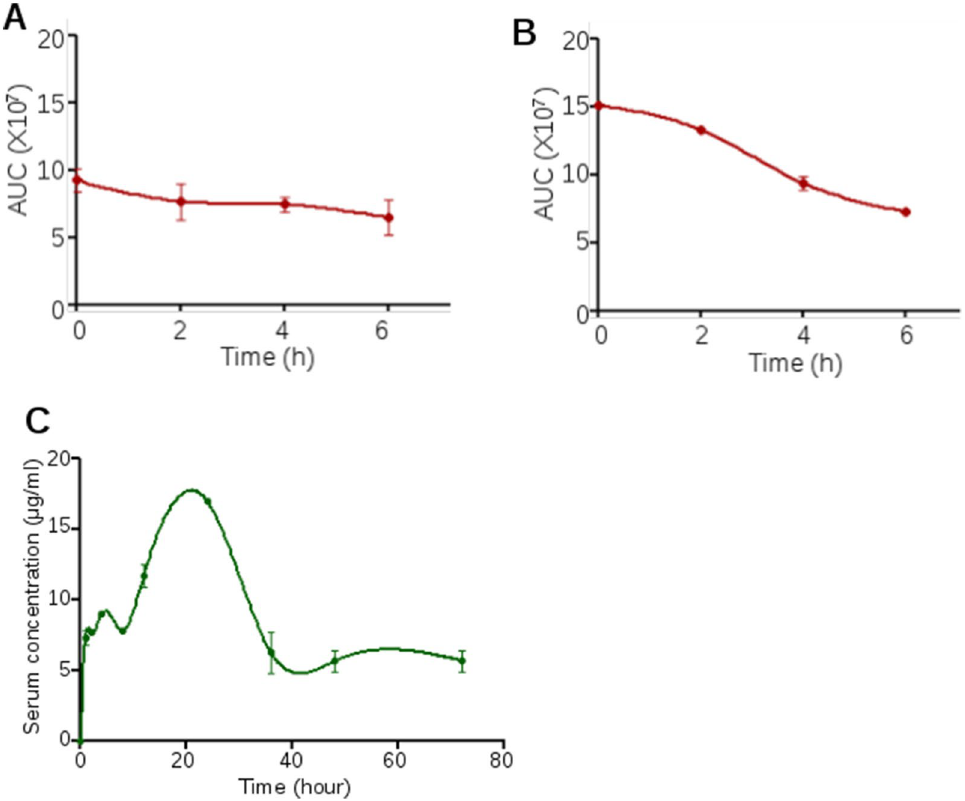
Figure 2. In vitro stability and in vivo bioavailability of Disarib in rats. ( A , B ) Stability analysis of Disarib at different time points (0, 2, 4 and 6 h) in PBS ( A ) and plasma ( B ). ( C ) In vivo bioavailability analysis of Disarib in the serum of Wistar rats at 0.25, 0.50, 1, 2, 4, 6, 8, 10, 12, 24, 48, 72 h after treatment. Two animals each were treated with Disarib orally and sera collected at each time points were subjected to HPLC analysis. The area under the curve (AUC) was calculated to obtain bioavailability. HPLC analysis were done at 232 nm